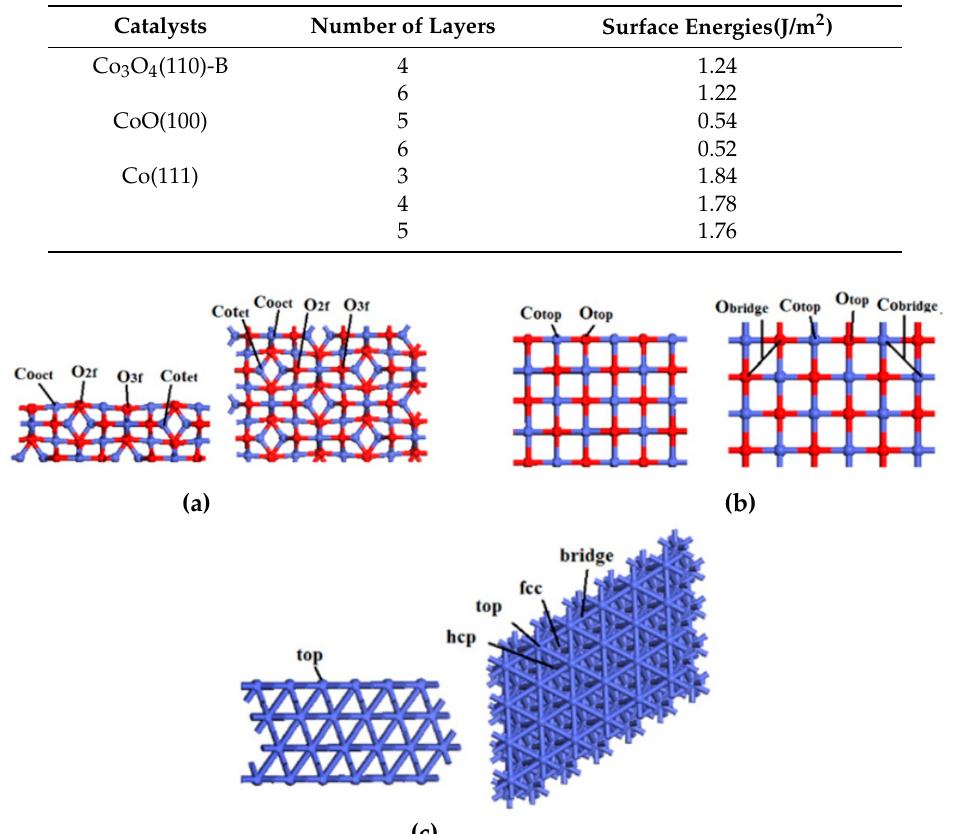
Figure 7. The top and side views of ( a ) Co 3 O 4 (110)-B, ( b ) CoO(100) and ( c ) Co(111) surfaces.